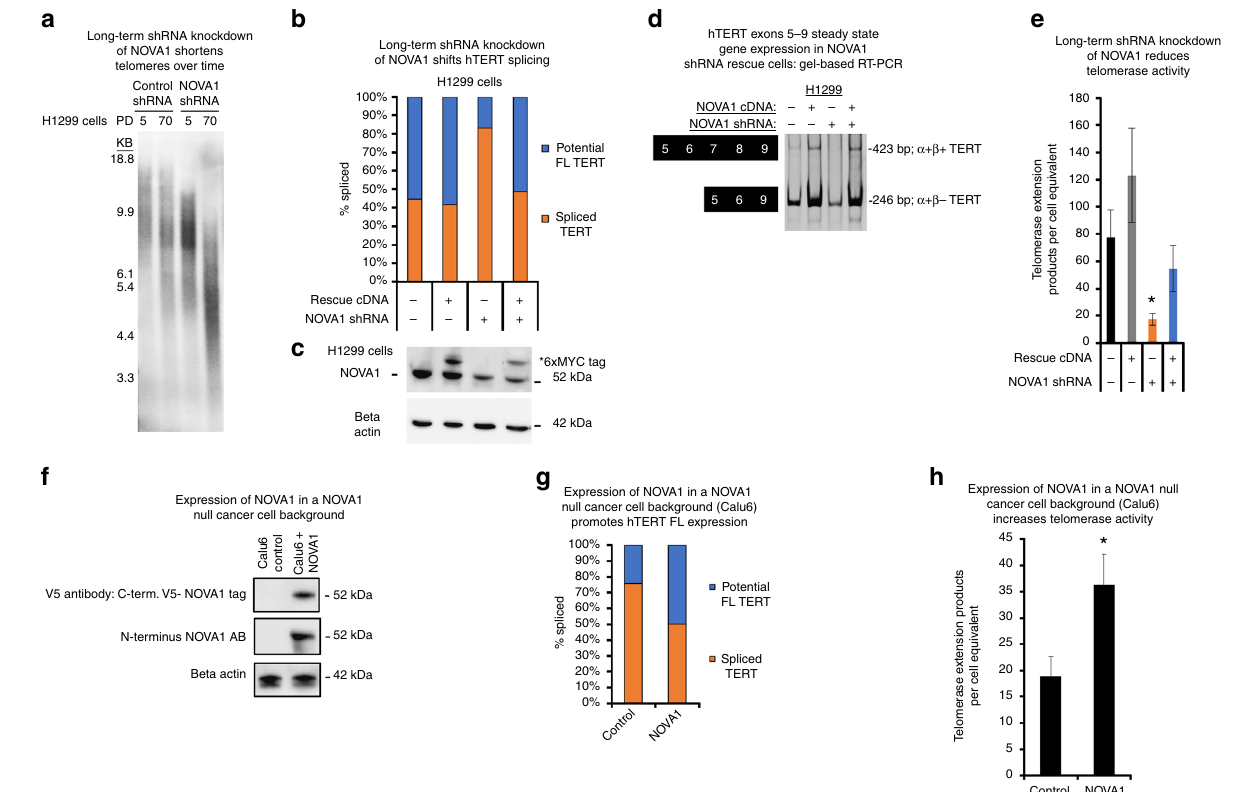
Fig. 2 Long-term reduction of NOVA1 progressively shortens telomeres. a Terminal restriction fragment length (TRF-Southern blot) analysis of control shRNA or NOVA1 shRNA at two population doublings (PD). b Rescue of shRNA knockdown of NOVA1 with a shRNA mutant cDNA in H1299 cells (stable cell lines were measured a minimum of six times over several passages). hTERT splicing was determined with RT-ddPCR assays. c Western blot of NOVA1 shRNA rescue in H1299 cells (representative image of stable cell lines, measured three times over three passages in culture). d hTERT expression in rescue H1299 cells as determined by RT-PCR of exons 5 – 9 (representative image; n = 3). e Rescue of shRNA knockdown of NOVA1 with a shRNA mutant cDNA partially restores telomerase activity in H1299 cells ( n = 6). Telomerase activity was determined with droplet digital TRAP (ddTRAP with 50 cell equivalents added to the assay). Student ’ s t test set at * p < 0.05 for signi fi cance. f Western blot of V5-tagged NOVA1 expression in Calu6 cells (representative image of stable cell lines). g hTERT splicing pro fi le in Calu6 cells with and without NOVA1 ( n = 6). hTERT splicing was determined with RT- ddPCR assays. h Telomerase enzyme activity (ddTRAP with 50 cell equivalents added to the assay) in Calu6 cells with and without NOVA1 ( n = 3). Student ’ s t test set at * p < 0.05 for signi fi cance). Data are expressed as means and standard error of the mean where applicable. * p < 0.05. RT: